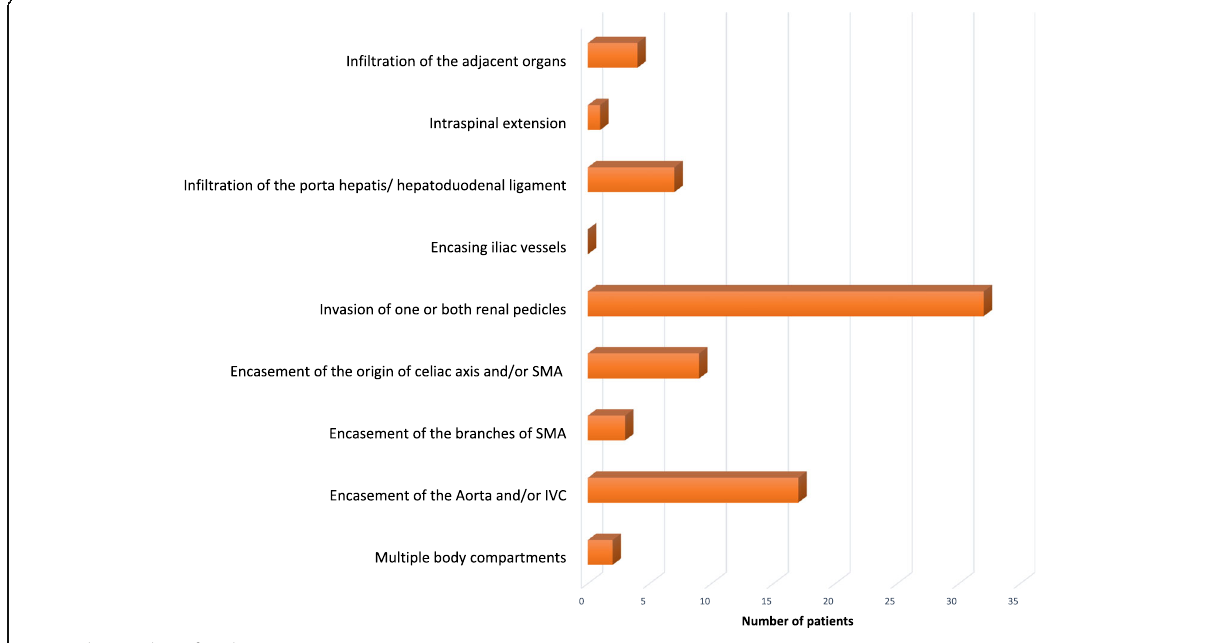
Fig. 2 The number of each pre-operative